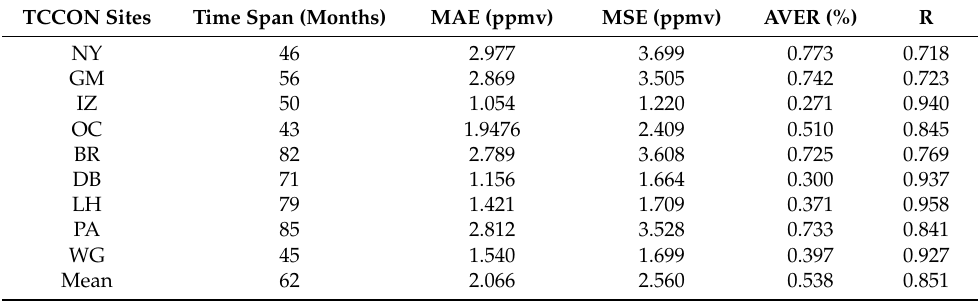
Table 7. Validation between TCCON and AIRS observations at 5–6 km observed